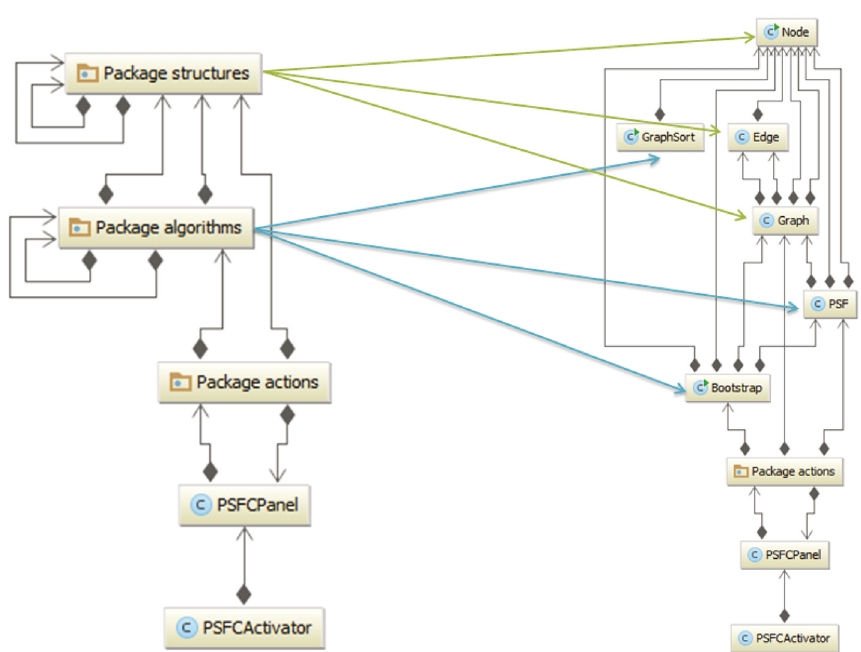
Figure 1. The PSFC class diagram. Only the main packages are displayed. In the right-hand diagram, the packages logic.algorithms and logic.structures are extended to respective classes. The communication from and to the user is performed via the PSFCPanel class and the gui.actions package. PSFC inherent structures and algorithms are implemented in the packages logic.algorithms and logic.structures . The classes extended from the packages logic.structures and logic.algorithms are shown with green and blue arrows, respectively. Class dependencies are indicated with grey